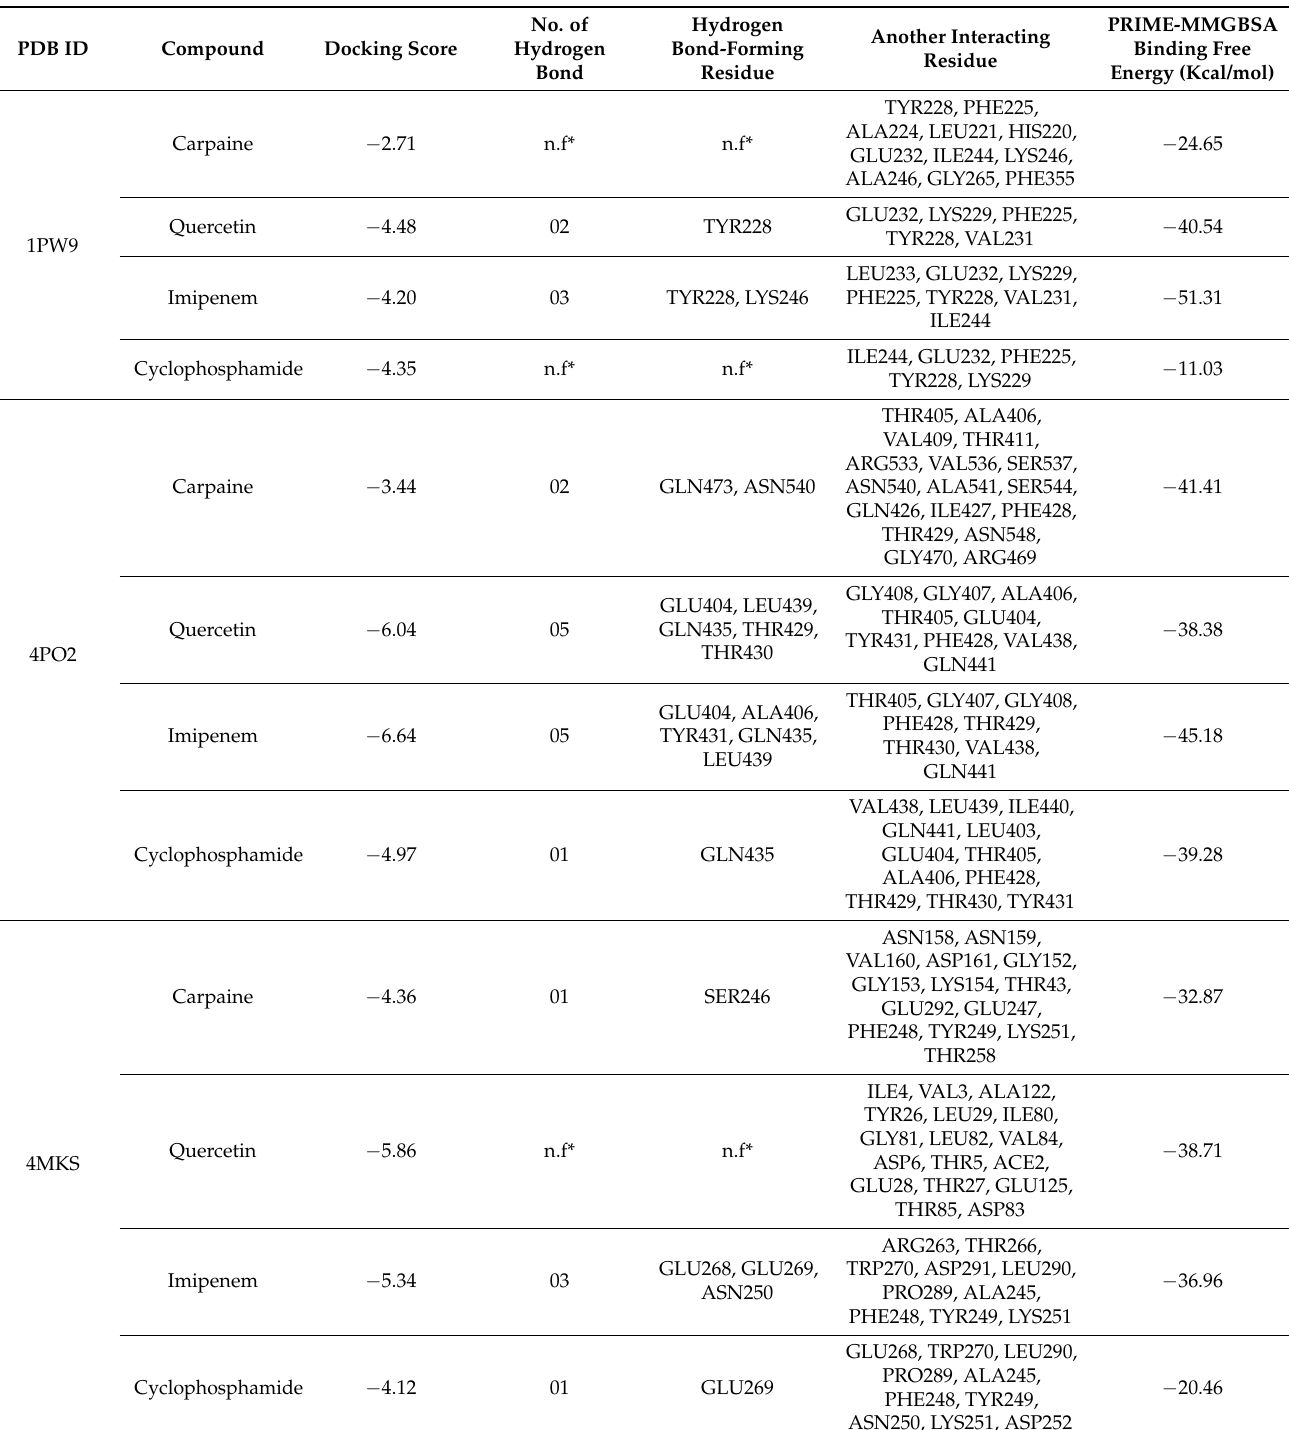
Table 1. Detailed information on molecular docking of bacterial proteins with the test and standard